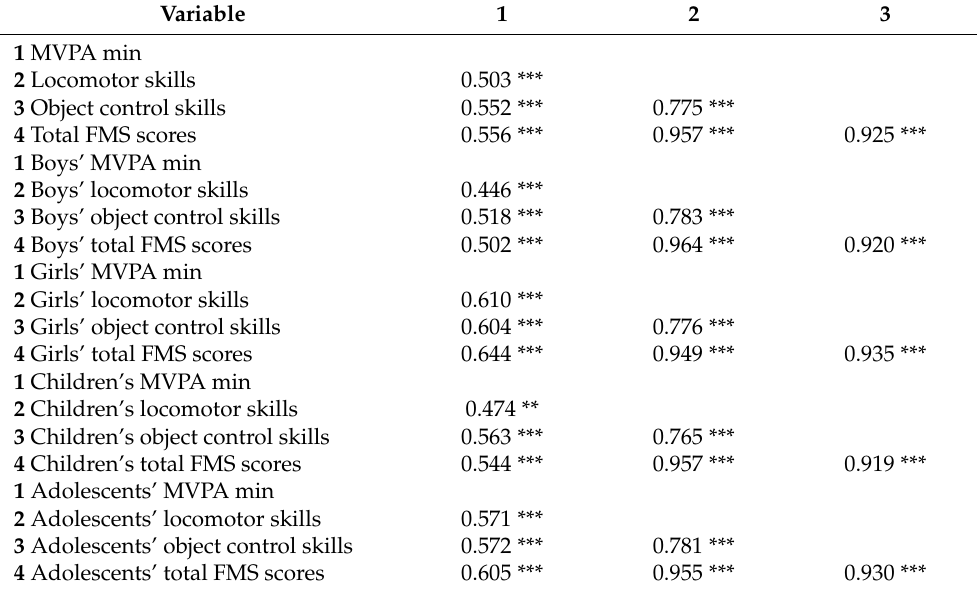
Table 5. Correlations (r) between MVPA and locomotor skills, object control skills, and FMS in participants with